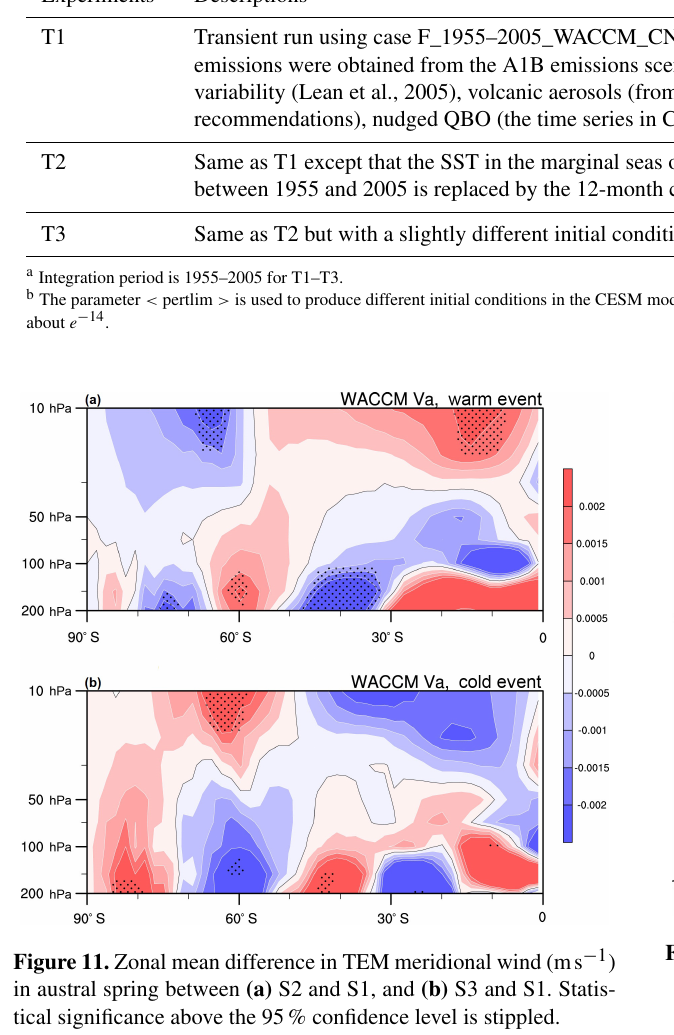
latitude lower-stratospheric ozone over the past 5 decades (Fig. 14, black line). The correlation coefficient between the two time series is 0.29, which is significant at 95 % confidence level. A further analysis reveals that the linear trend of ozone variations over the region 60–90 ◦ S at 200– 50 hPa from T1 (Trend 1) is − 1.2 × 10 − 3 ppmvmonth − 1 , from T2 (Trend 2) is − 1.0 × 10 − 3 ppmvmonth − 1 , from T3 (Trend 3) is − 0.89 × 10 − 3 ppmvmonth − 1 , and from (T1 − (T2 + T3) / 2) (Trend 1_23, Fig. 14, black line) is − 0.2 × 10 − 3 ppmvmonth − 1 . See Table 4. It implies that approximately 17 % of the declining trend in southern high-latitude lower-stratospheric ozone from 1955 to 2005 (Trend 1_23 / Trend 1 × 100 %) may be related to the in- creasing linear trend in SST over the marginal seas of East